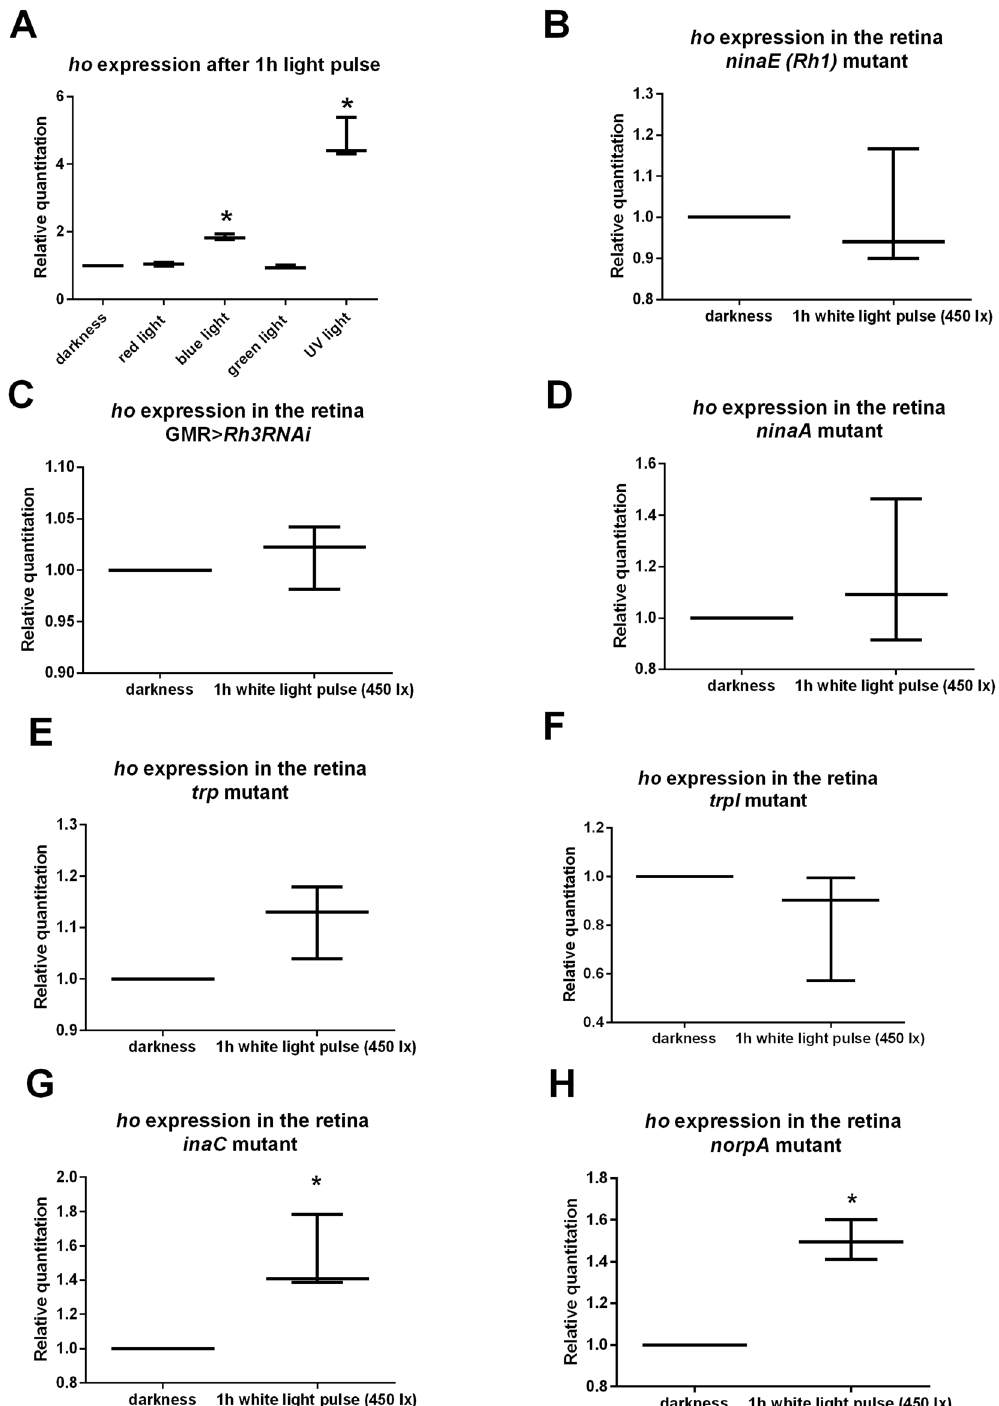
Figure 4. ( A ) The ho mRNA level in the retina after 1 h exposure to different wavelengths of light. ( B – H ) The ho mRNA level in the retina after 1 h of white light exposure. Data are normalized to DD (value = 1.0). Statistically significant differences are marked with asterisks. ( B ) GMR > Rh3RNAi , ( C ) ninaE , ( D ) ninaA , ( E ) trp , ( F ) trpl , ( G ) inaC , ( H ) norpA . The ends of the vertical bars for each time point represent the range of findings, with the more centrally located horizontal bars the